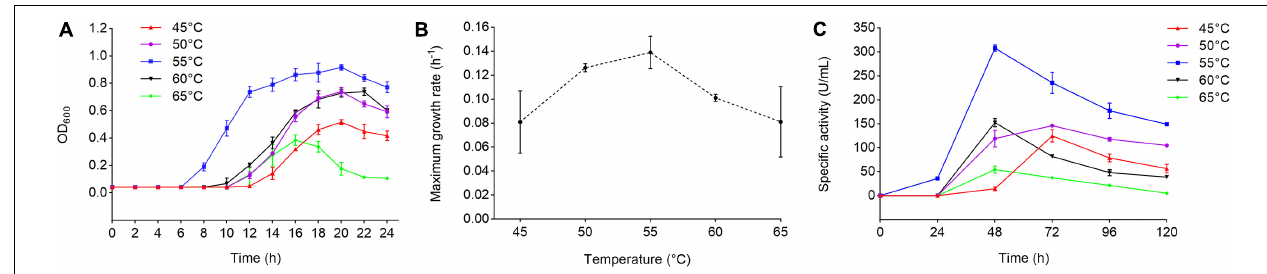
FIGURE 1 | Growth and protease production of strain 1A02591 at different temperatures. (A) Growth curves of strain 1A02591 at temperatures from 45 ◦ C to 65 ◦ C. Strain 1A02591 was cultured in liquid 2216E medium at pH 7.5 and cell growth was monitored by measuring the OD 600 of the culture. (B) Maximum specific growth rate of strain 1A02591 at 45, 50, 55, 60, and 65 ◦ C. The growth rate of strain 1A02591 was measured by the increment of OD 600 per hour at each temperature and was fitted by DMfit v3.5 using Gompertz model. (C) The extracellular protease production of strain 1A02591 cultured at temperatures from 45 ◦ C to 65 ◦ C. Strain 1A02591 was cultured in a fermentation medium as described in section “MATERIALS AND METHODS,” and the protease activity in the culture was measured at 70 ◦ C with casein as the substrate. The graphs show data from triplicate experiments (mean ± SD).